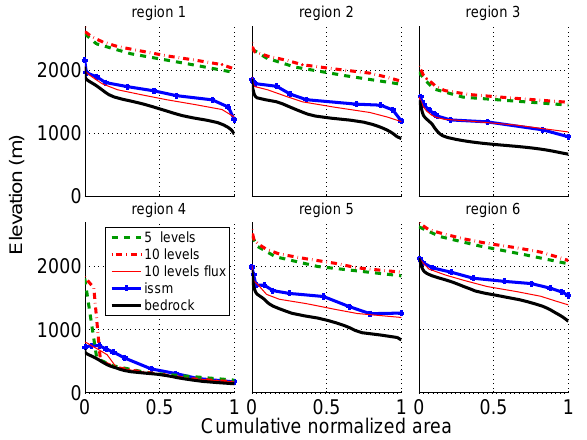
Figure 8. Surface elevation generated by the ISSM (solid blue line), the SG model with no flux term, using 5 and 10 hypsometric bins, (dotted lines) and the SG model including the flux term (solid thin red line). These simulations use a constant sea level temperature of 0 ◦ C and a desertification effect factor of 0.5. Results are shown at steady state after 2kyr for six different regions with different topo- graphic characteristics.